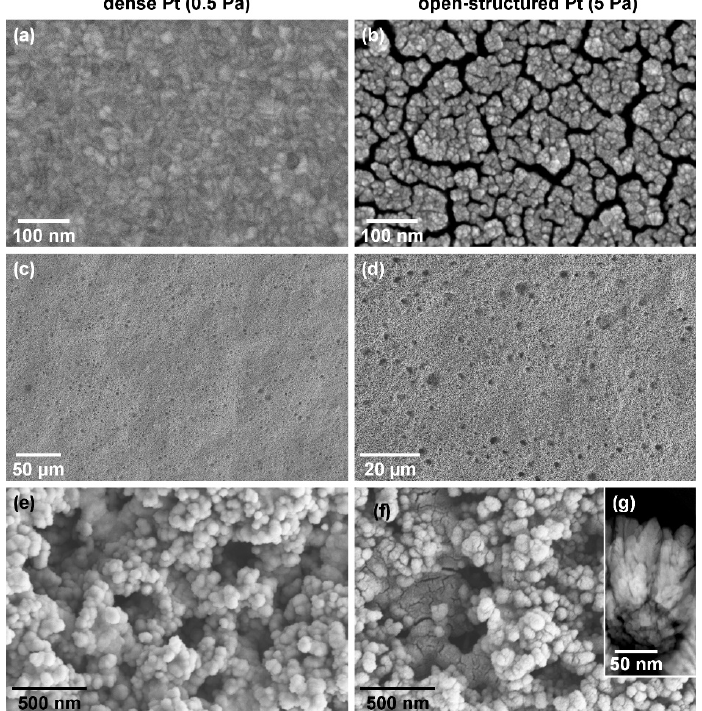
Figure 1. Electrode microstructure: representative plane-view scanning electron micrographs of 60 nm thick dense (left-hand side) and open-structured (right-hand side) platinum thin films deposited onto a Si substrate ( a , b ) and onto a carbon paper ( c – g ), respectively. Micrographs ( c ) and ( d ) present an overview of the morphology of the GDEs, whereas the micrographs ( e ) and ( f ) show detailed images. Micrograph ( g ) represents a cross-sectional image of the open-structured Pt thin film.